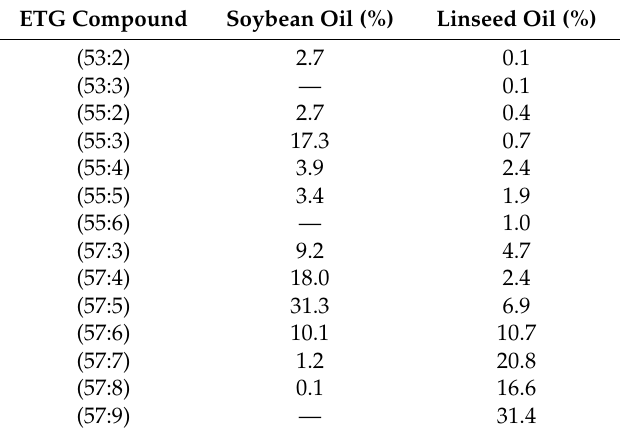
Table 1. The relative intensities of the identified saturated epoxidized oil components determined by MALDI-TOF MS. The epoxidized triglycerides (ETG) compounds are defined by their number of carbon atoms and epoxide groups. ETG Compound Soybean Oil (%) Linseed Oil